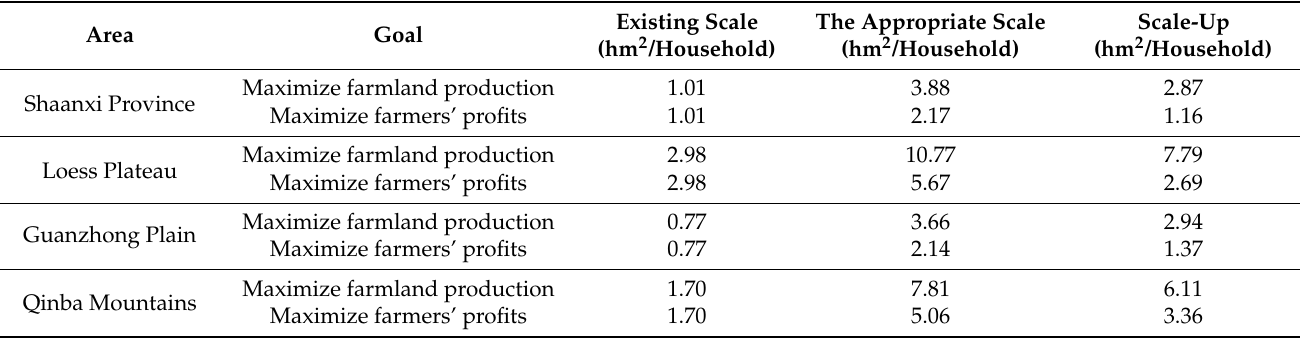
Table 3. The appropriate scale of farmland management per household for farmers under different